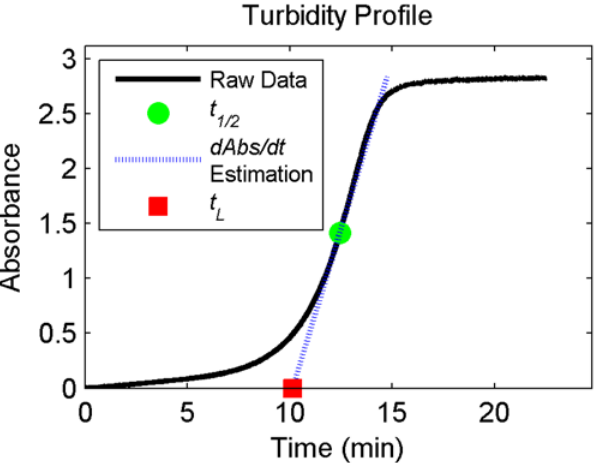
Fig 1. Representative turbidity profile annotated with quantitative metrics. Data shown is for 8 mg/ml collagen polymerized at pH 7.9 and 23°C.